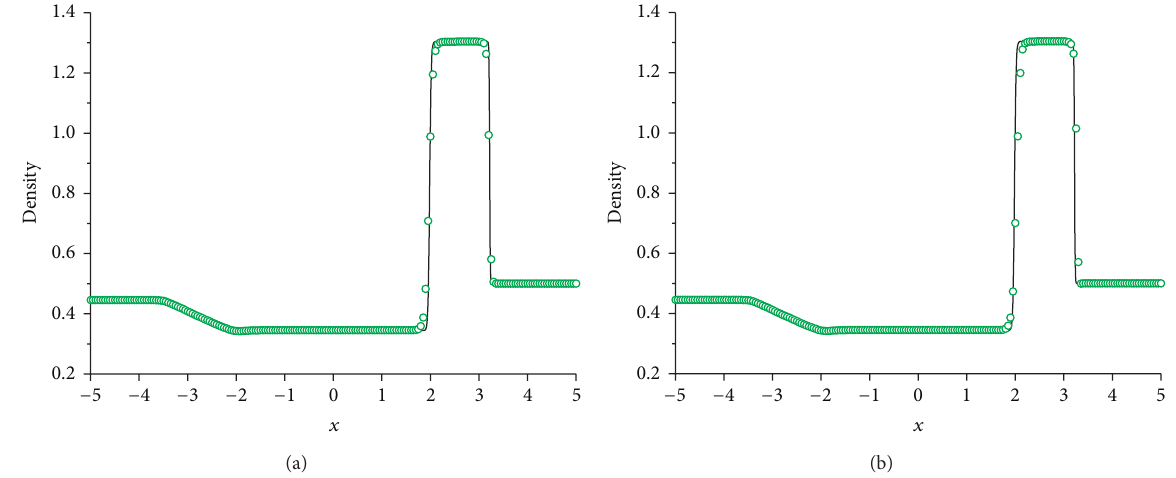
Figure 4: The numerical results of the lax problem at 𝑡 = 1.3 with CFL = 9.9 , 𝑁 = 200 ; (a) M-SL-FV WENO 5 scheme; (b) M-C-SL-FD WENO 5 scheme; solid line: exact solution; circle: computed